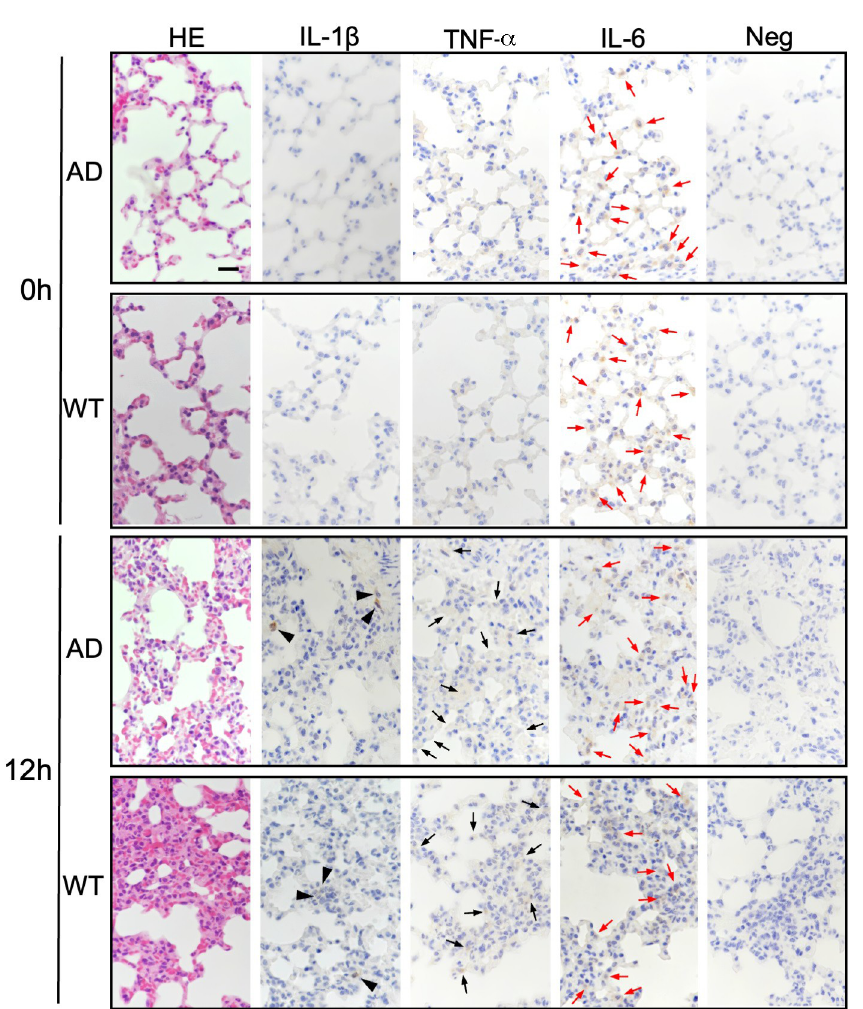
Fig 8. Immunohistochemical comparison of IL-1 β , TNF- α , and IL-6 expression in the lungs of WT and AD mice after LPS challenge. Formalin-fixed and paraffin-embedded specimens from lung were stained with hematoxylin and eosin (HE). Serial sections were immunostained with antibodies specific for IL-1 β , TNF- α , or IL-6. A negative control (Neg) (lacking the primary antibody) is also included. Positive staining for IL-1 β , TNF- α , and IL-6 is indicated by arrowheads, black arrows, and red arrows, respectively. 0 h, before LPS challenge; 12 h, 12 h after LPS challenge. AD, ASC-deficient; WT, wild-type. Bar = 100 μ m.